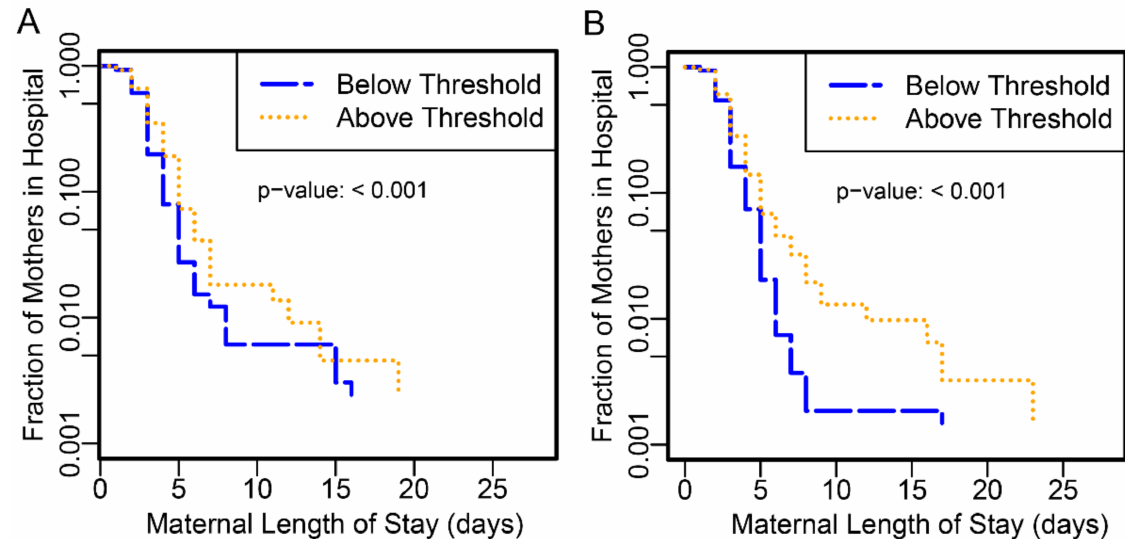
Figure 2. Kaplan–Meier curve of maternal length of stay in days. The fraction of mothers remaining in the hospital is plotted as a function of the length of hospital stay in days. Women without recorded hospital stays were omitted ( A :3, B :0). Verification phase subjects from the PAPR study ( A ) and validation phase subjects from the TREETOP study ( B ) were stratified into higher- (gold) and lower-risk (blue) groups defined by the proteomic biomarker threshold of − 1.37.